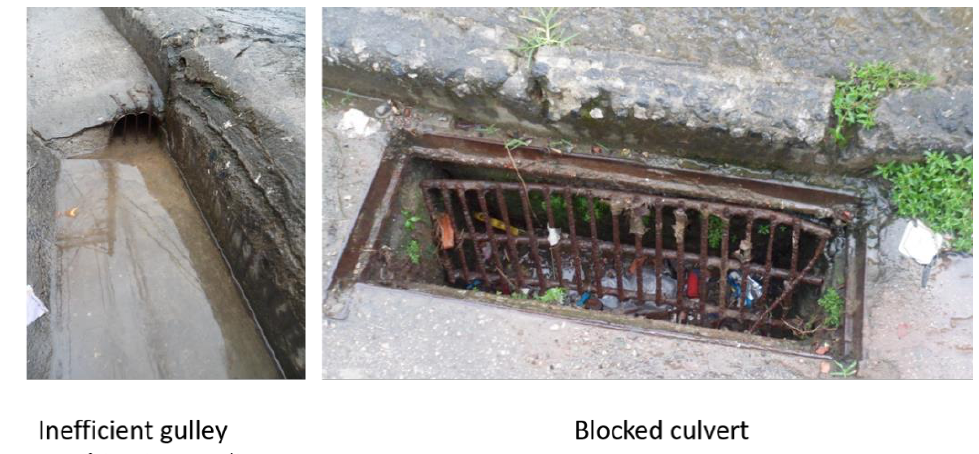
Figure 3. Conventional drainage, Ouro Preto, blocked with solid waste.